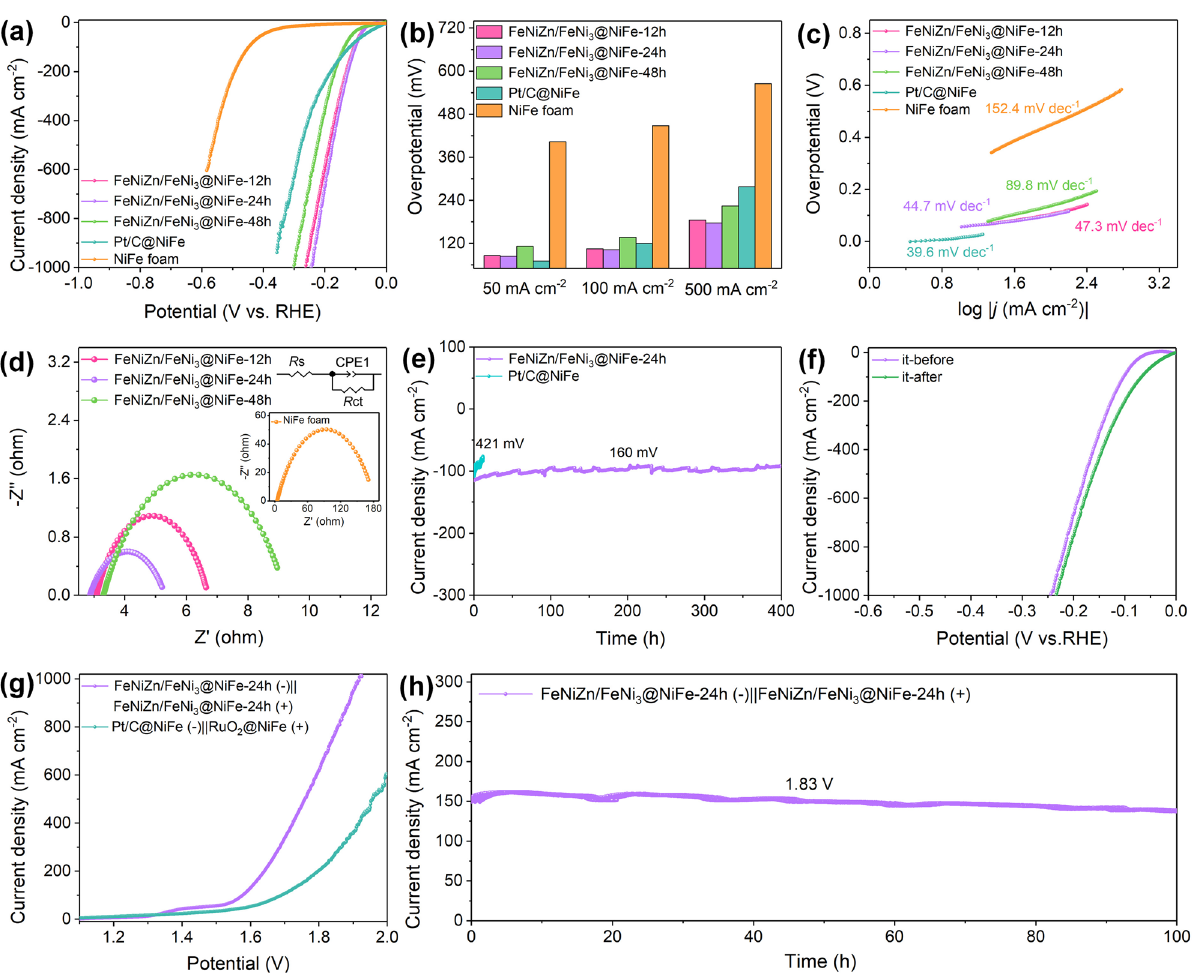
Fig. 6 a LSV curves of FeNiZn/FeNi 3 @NiFe samples, Pt/C@NiFe, and NiFe foam in 1.0 M KOH solution at the scan rate of 5 mV s −1 . b Overpotentials of all electrodes at different current densities. c Tafel plot. d EIS data of FeNiZn/FeNi 3 @NiFe samples and NiFe foam. e i–t curve under the overpotential of 160 and 421 mV for FeNiZn/FeNi 3 @NiFe-24 h and Pt/C@NiFe, respectively, and f LSV curves at a scan rate of 5 mV s −1 before and after i–t test for FeNiZn/FeNi 3 @NiFe-24 h toward HER. g LSV curves for overall water splitting with FeNiZn/FeNi 3 @ NiFe-24 h and Pt/C@NiFe (−)||RuO 2 @NiFe (+) in a two-electrode device. h i–t test for FeNiZn/FeNi 3 @NiFe-24 h at a constant potential of 1.83 V in a two-electrode